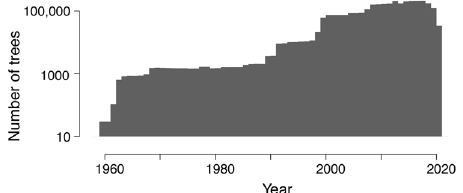
Fig. 6 Distribution of observation trees by year in the North American region of the MASTIF network. Sites are listed by ecoregion in the Supplementary Data 2.